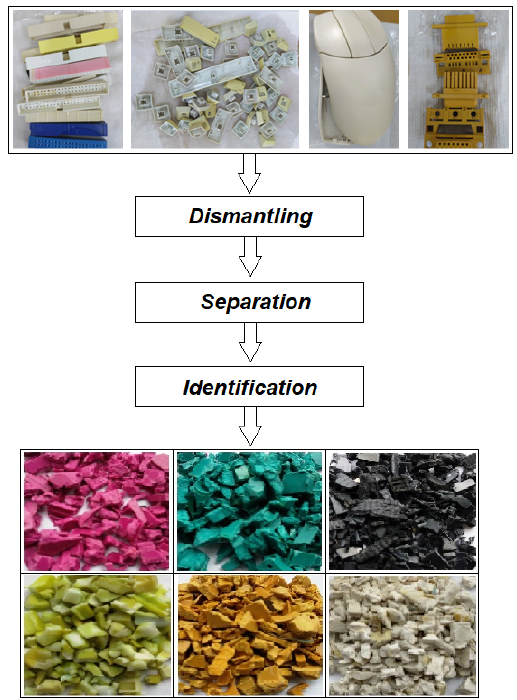
Figure 2. Flow chart of the recycling process until obtaining individual polymers [5].